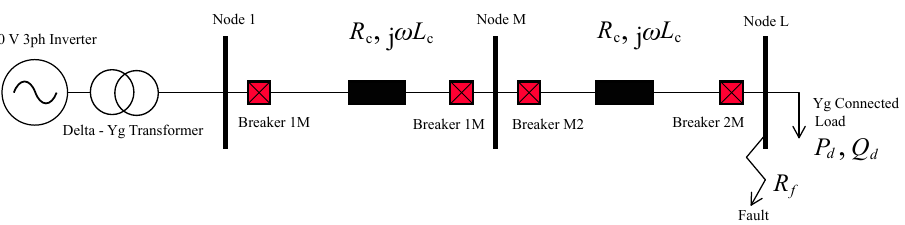
Figure 12. Oneline diagram of the Three-Node Islanded Microgrid System.